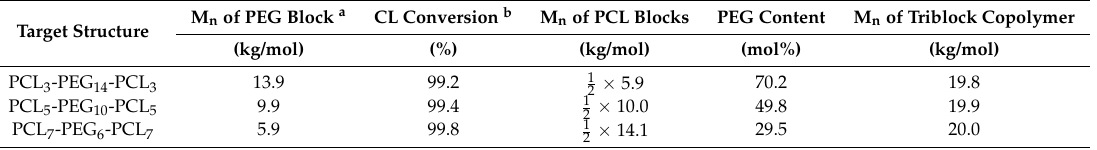
Table 1. The composition and PEG and PCL block lengths of synthesized PCL- b -PEG- b -PCL triblock copolymers as determined by 1 H-NMR after purification.